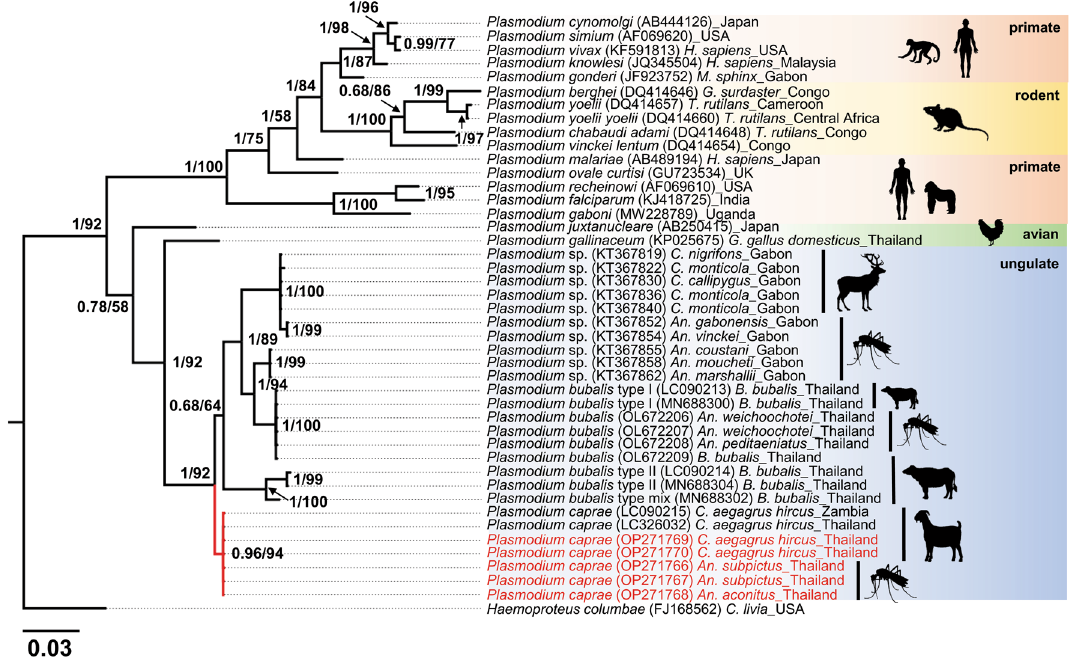
Figure 2. The phylogenetic position of P. caprae detected from Anopheles mosquitoes and goat blood in this study. The phylogenetic tree was inferred by Bayesian inference using partial cytb sequences (632 bp) with the Haemoproteus columbae sequence as a root. The posterior probabilities are given by Bayesian inference, and the bootstrap values by Maximum likelihood (≥ 0.68/58) are given in the nodes. Sequences obtained in this study are highlighted in red, and reference sequences retrieved from the GenBank database are highlighted in black. The length of substitutions/site (0.03) is